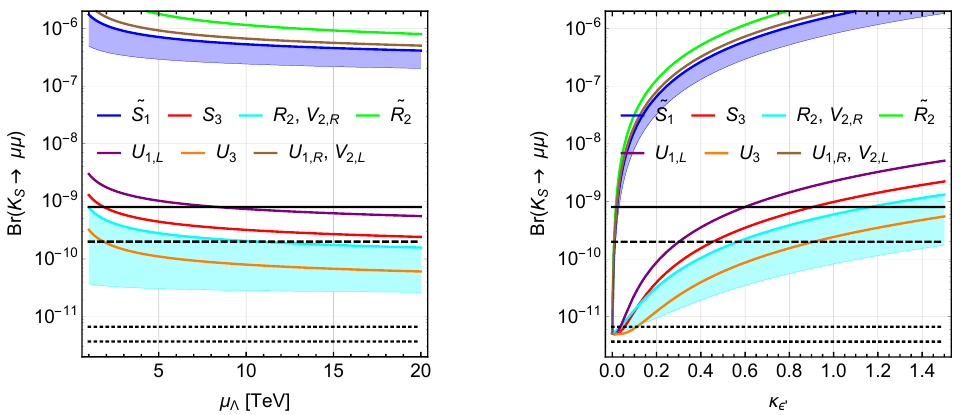
Figure 6. The dependence of B ( K S ! (cid:22) (cid:22) (cid:22) ) on the new physics scale (cid:22) (cid:3) (cid:24) M LQ for (cid:20) " 0 = 0 : 5 [left] and on (cid:20) " 0 for (cid:22) (cid:3) = 20 TeV [right]. For U 1 and V 2 , it is assumed that either only L -LQ or only R -LQ couplings are present and saturate (cid:20) " 0 . Further shown are the current upper experimental bound on B ( K S ! (cid:22) (cid:22) (cid:22) ) from LHCb [black solid], a conservative future prospect for LHCb with 23 fb (cid:0) 1 [black dashed] and the SM prediction [49] [black dotted]. (cid:22) = 20 TeV. The models e R (and V ) and S , U require B ( K + ! (cid:25) + (cid:23) (cid:22) (cid:23) ) > 10 (cid:0) 9 2 1 3 (cid:3) 2 ;L